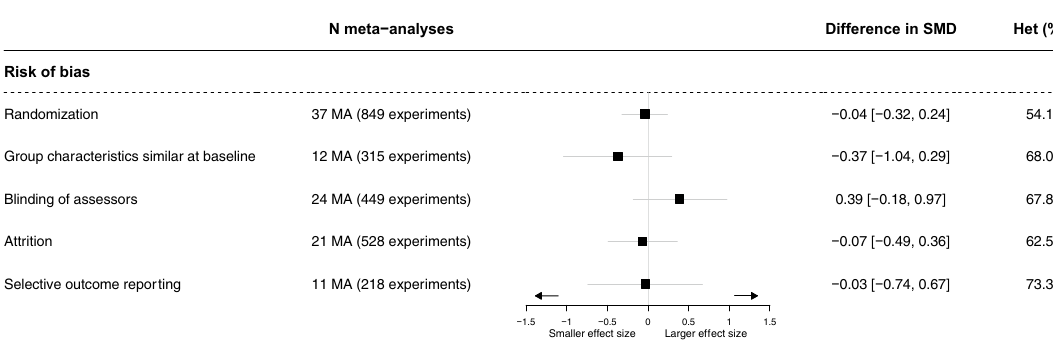
Figure 2. Difference in standardized mean difference (SMD) for risk of bias estimated by a meta- epidemiological analysis. A positive difference in SMD reveals a larger effect size in studies at high or unclear risk of bias. A negative difference in SMD indicates a smaller effect size in case of threats to methodological quality. Het heterogeneity, MA